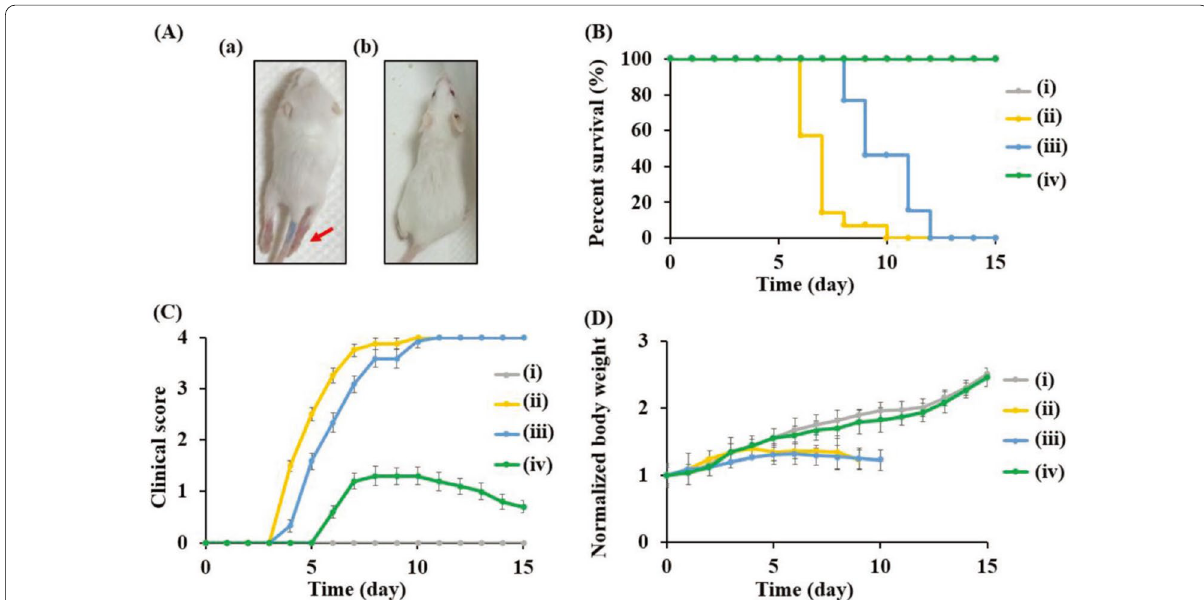
Fig. 9 A Representative photographs of mice on day 7 post-infection (a) without and (b) treated with Cur-CQDs-180 (25 mg kg − 1 ). The red arrow indicates apparent limb paralysis in the untreated infected mice. B survival rates, C clinical scores, and D body weights of (i) newborn mice without infection and (ii iv) newborn mice intraperitoneally injected with (ii) PBS, (iii) curcumin (25 mg kg − 1 ), or (iv) Cur-CQDs-180 (25 mg kg − 1 ) followed − by intraperitoneal injection of EV71 at the dose of 2 10 6 PFU. A group of uninfected mice treated with sterile PBS was used as an uninfected × control. The curcumin or Cur-CQDs-180 treatment was performed every 12 h daily for seven consecutive days. The mice were monitored for 15 d